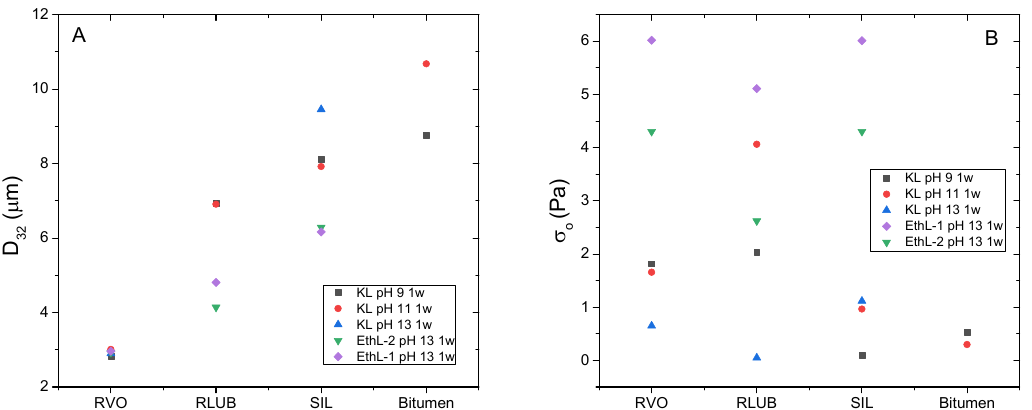
Figure 9. Sauter mean diameters ( A ) and yield stress values ( B ) of emulsions stabilized by bioethanol ‐ derived and Kraft lignins formulated at different pH and stored for one week.